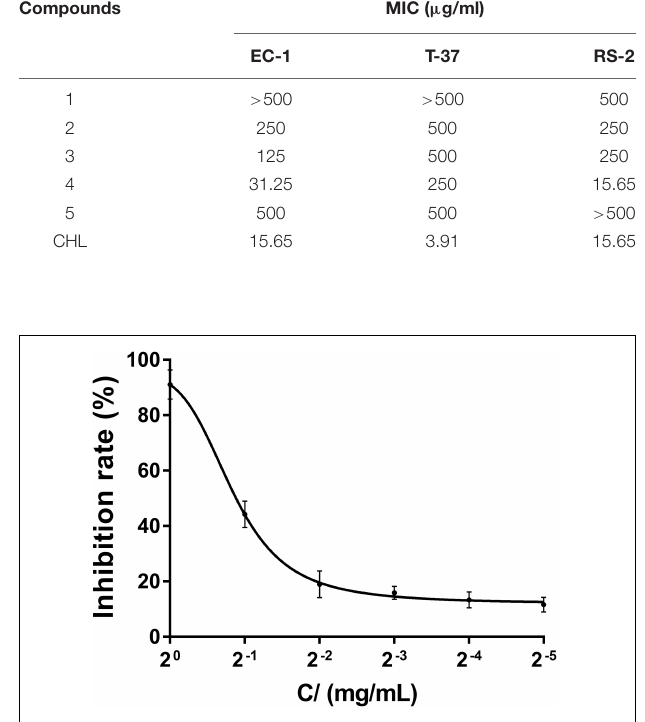
FIGURE 5 | The EC50 value of compound 4 against